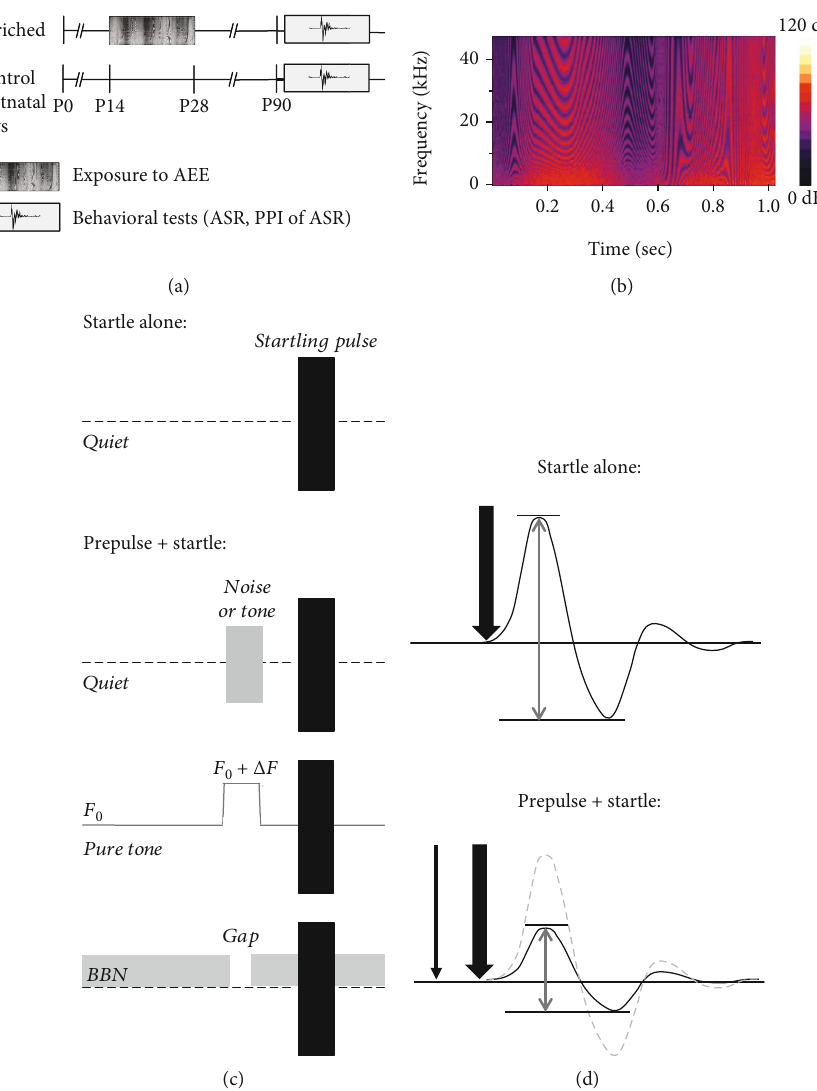
Figure 1: Schematic illustration of the experimental paradigm: (a) time schedule of the experiment; (b) a representative spectrogram of the background rippled noise used for AEE; (c, d) behavioral test arrangement: (c) diagram illustrating trials in testing sessions; (d) representative responses to startle alone trial and startle response in the presence of